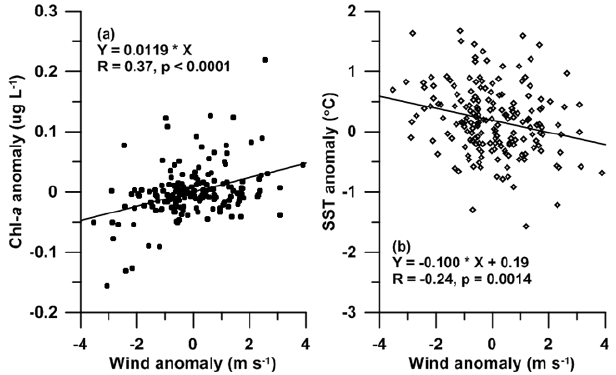
Fig. 10. The correlation between anomalies of Chl and wind speed (a) and between anomalies of SST and wind speed (b) .